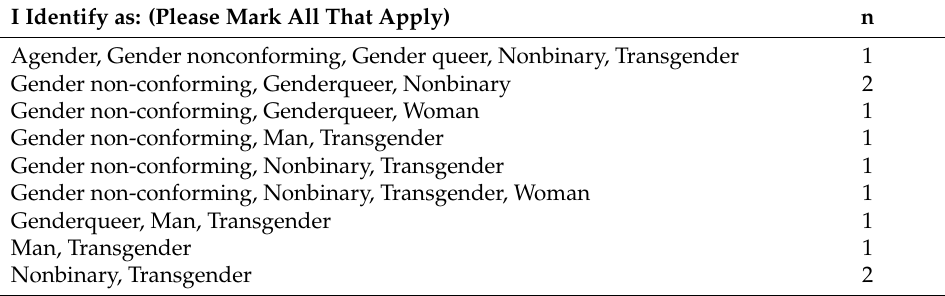
Table 2. Gender identity of participants.